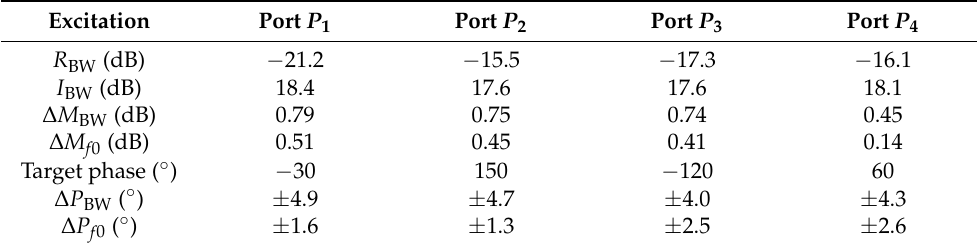
Table 1. Butler matrix 1: performance figures of the optimized structure (EM simulation).